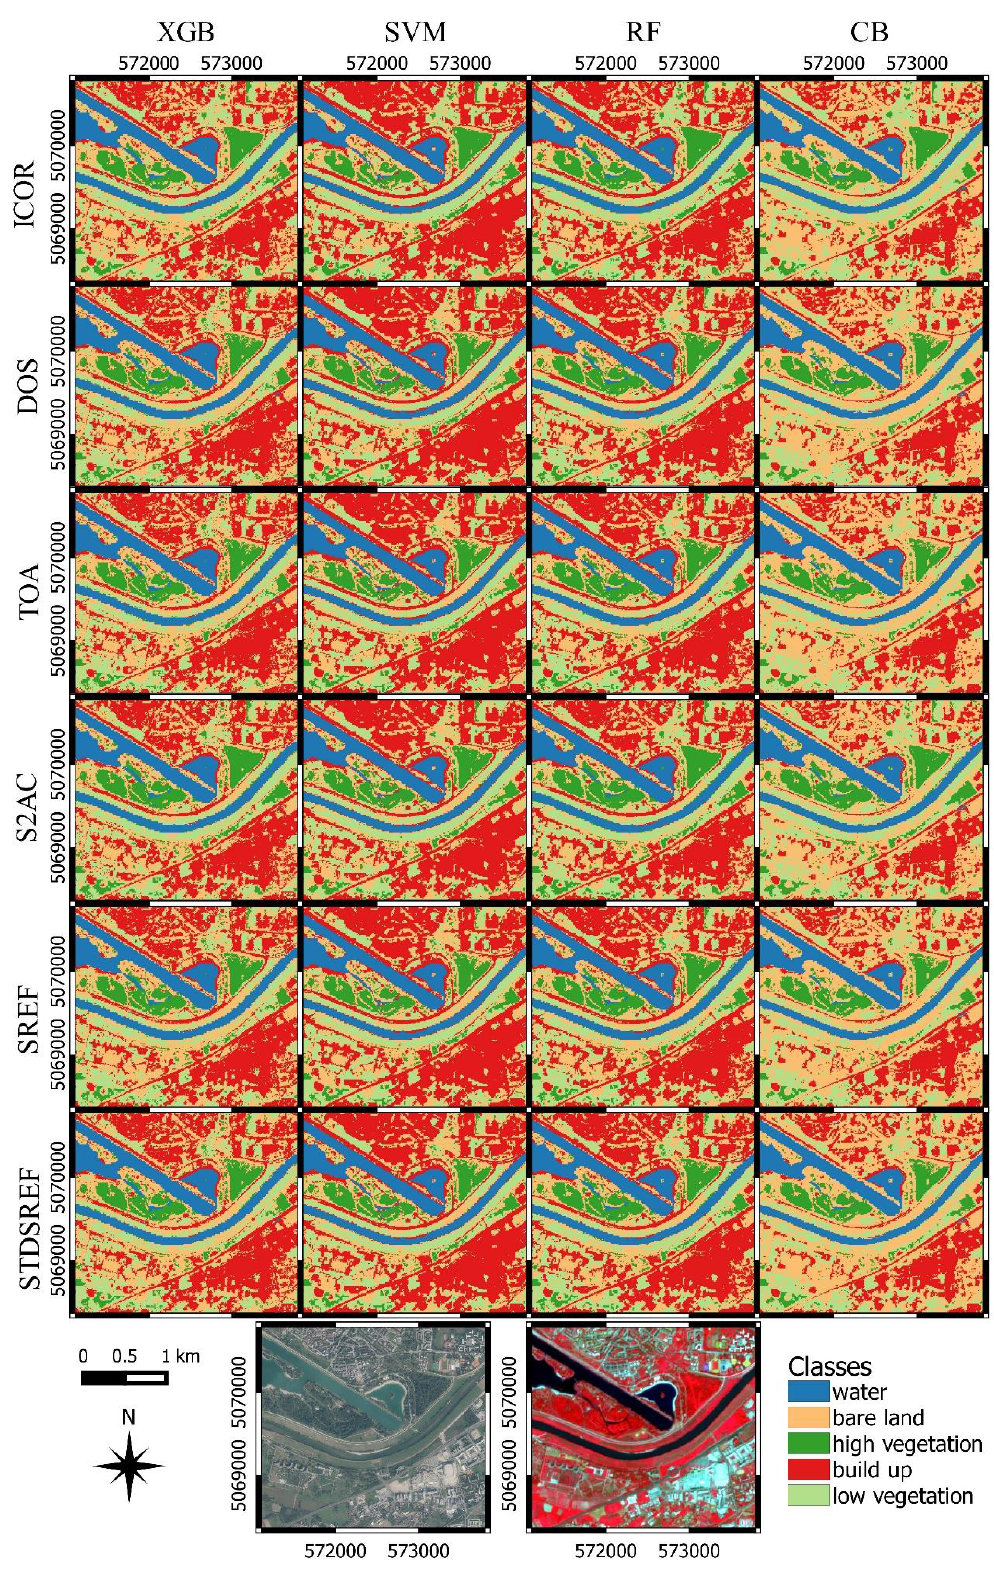
Figure 9. Classification maps for 12 June 2018 for four classification techniques and six atmospheric